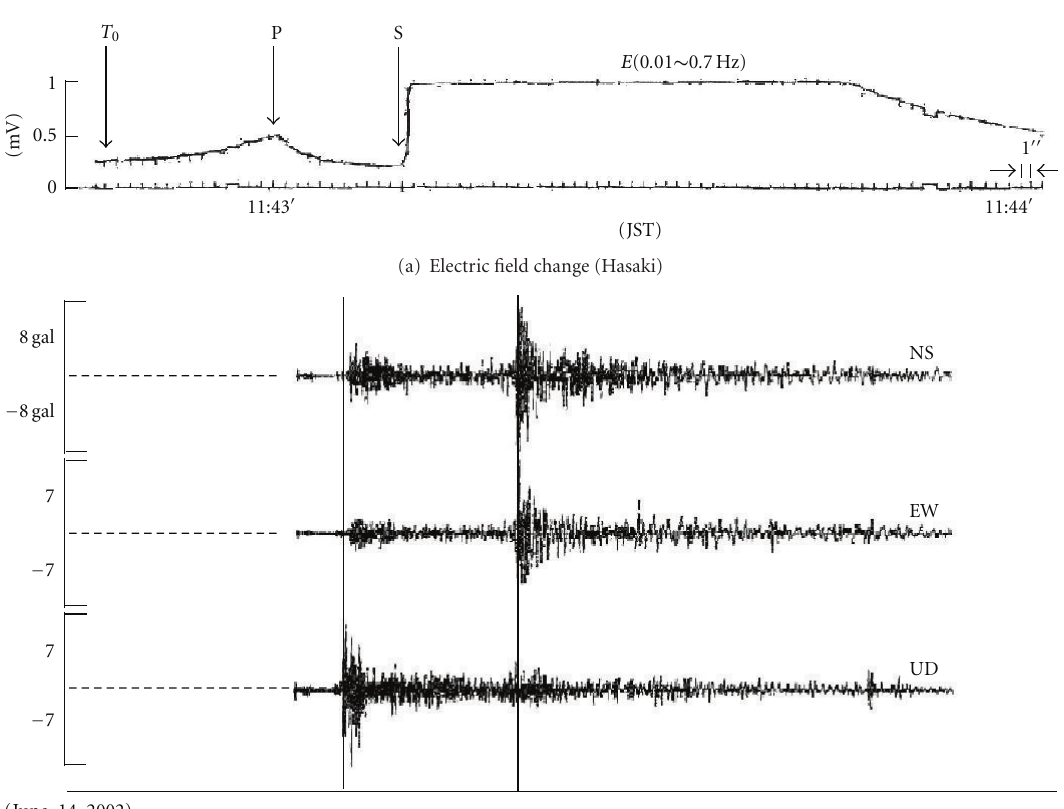
Figure 3: A high-speed analog monitoring record including the ULF components of electric field variation is shown in the upper part (a), and three components of a strong motion seismic record at Choshi of K-NET (b) are shown in the lower part. (a) In the high-speed recording, the time resolution is 1sec and the clock is calibrated every second, assuring accuracy to within 1ms. The vertical bar shows the origin time of the earthquake determined by Hi-net data by NIED, and the arrival of P and S waves at Hasaki was estimated from the seismogram at Choshi (b). The starting time of the anomaly was 11h 42m 49.0 s ( ± 1s), near the origin time of the earthquake, T 0 = 11 h 42m 50.0 s. (b) The strong motion record of the earthquake at Choshi (+ in Figure 1). The time axis of the strong motion record is shifted corresponding to the position di ff erence of the electric field variation at Hasaki to the K-net site Choshi in the epicentral direction. We can see that the ULF component of electric variation evolved in good correlation with seismic wave